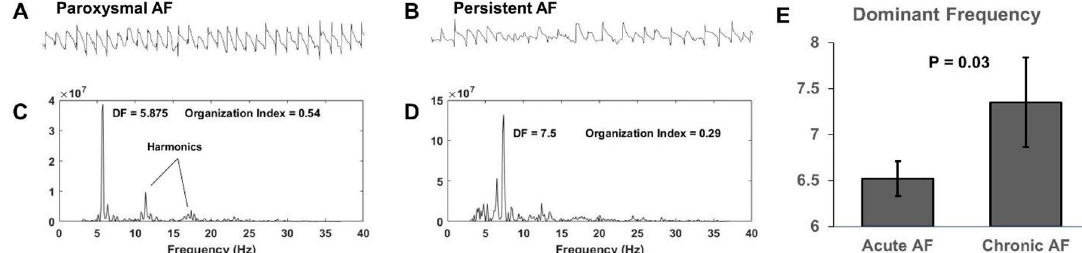
Fig 2. Persistent AF increased left atrial dominant frequency. Left atrium electrograms of (A) paroxysmal and (B) persistent AF. Paroxysmal AF animals had comparatively more organized baseline activity compared to Persistent AF. (C-D) Example frequency spectra derived from the respective electrograms; paroxysmal AF was characterized by more organized activity as evident by the presence of strong harmonics. Conversely, harmonic frequencies were less distinct in persistent AF electrograms. (E) There was a significant increase in mean DF from paroxysmal to persistent